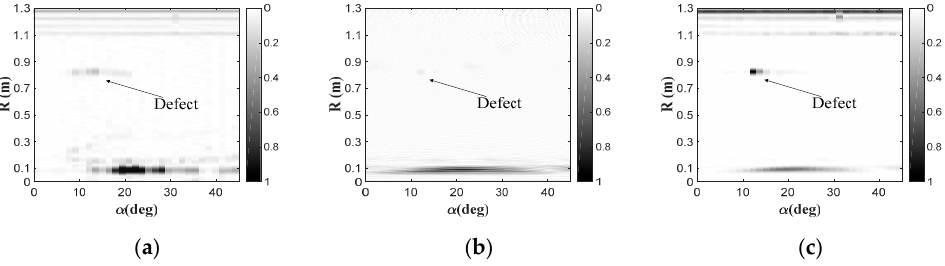
Figure 15. Experimental images by the three methods: ( a ) B-scan; ( b ) DAS; ( c ) CSAFT. Table 3. Defect estimation by the three methods.